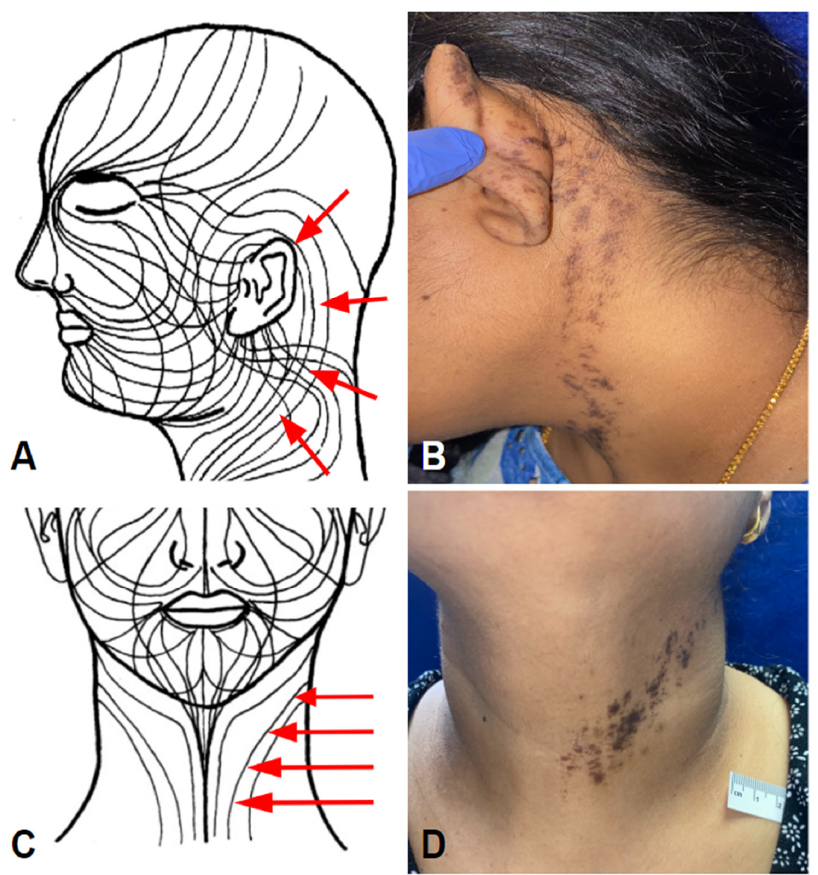
Figure 8. V-ILE Case 4, lichen striatus-like. Schematics showing Blaschko’s lines on head and neck; ( A ) lateral and ( C ) frontal views. Reproduced from Happle, R.; Assim, A. J. Am. Acad. Dermatol. 2001 , 44 , 612–615. ( B ) Starting superiorly and posteriorly at the left ear. ( D ) A purple-brown band extends inferiorly and medially to terminate abruptly at the midline of the neck.